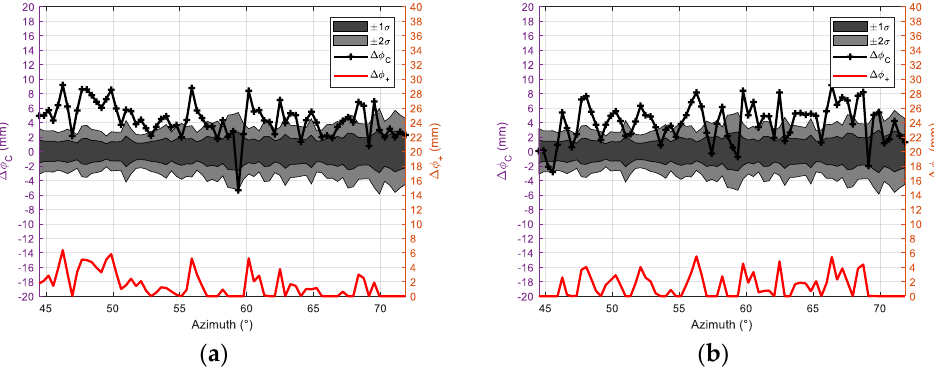
Figure 11. Examples of phase shift from two rainy days: ( a ) on 27 June 2015; ( b ) on 10 August 2015.